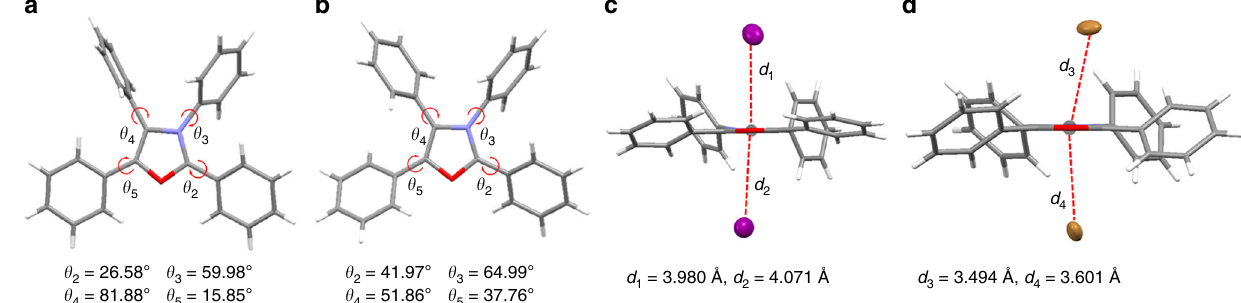
Fig. 2 Single-crystal X-ray diffraction analysis. Torsion angles and anion – π + interactions with distances for a , c TPO-I and b , d TPO-Br,